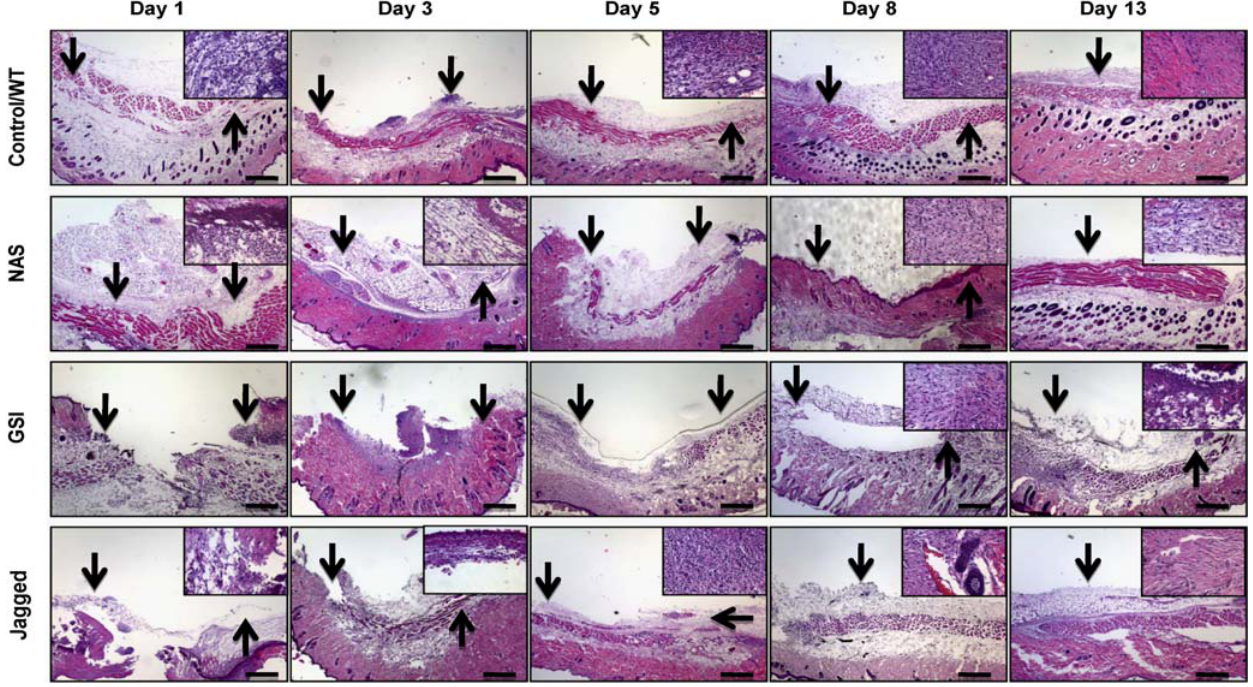
Figure 2. Histological features of wound healing in mice with decreased or increased Notch activity. Images of skin tissue sections stained with hematoxylin and eosin showing histological changes during the wound healing process in non-transgenic control mice, NAS mice, GSI (100 m M DAPT) treated mice and 15 m M Jagged peptide-treated mice at post-injury days 1, 3, 5, 8 and 13. NAS and DAPT-treated mice exhibited delayed wound healing, and Jagged peptide-treated exhibited enhanced wound healing, compared to control mice. See Supplementary histological evaluation (Text S2) for a detailed description of histological changes in the different groups of mice. Scale bar=0.5 mm